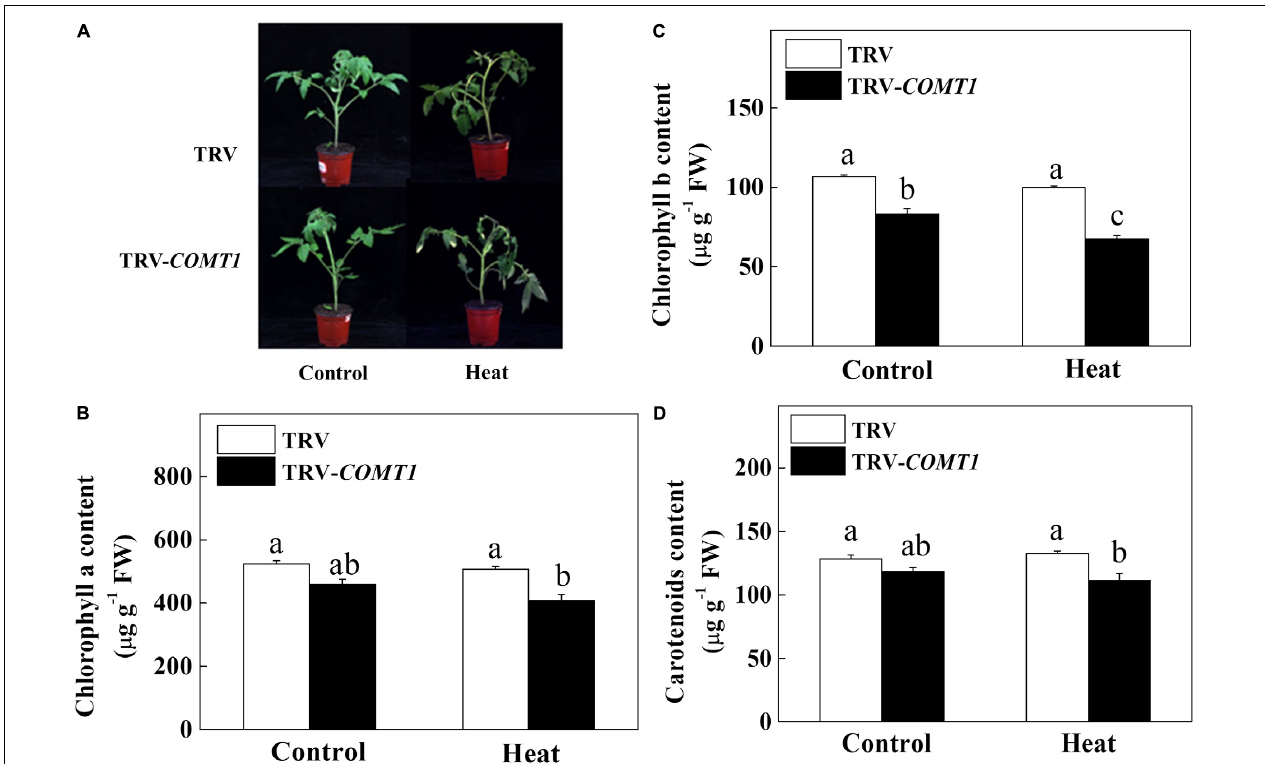
FIGURE 1 | Effects of COMT1 silencing and heat stress on plant phenotype and photosynthetic pigment concentration. (A) Plant phenotype, (B) chlorophyll a content, (C) chlorophyll b content, and (D) carotenoids content in third fully expanded leaves. Tomato seedlings at five-leaf stage were exposed to 40 ◦ C temperature for 9 h before analysis of the phenotype and pigment contents. The results are expressed as the mean values ± SE, n = 6. The mean values denoted by the same letter do not significantly differ at a P < 0.05 according to the Tukey’s